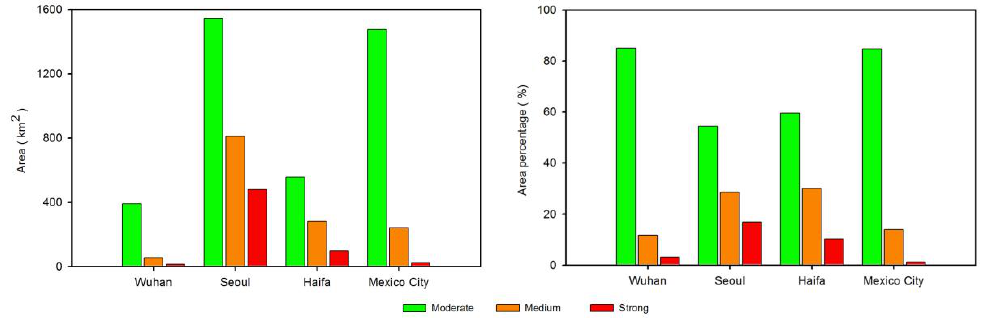
Figure 11. The areas and area percentages of different light pollution levels.